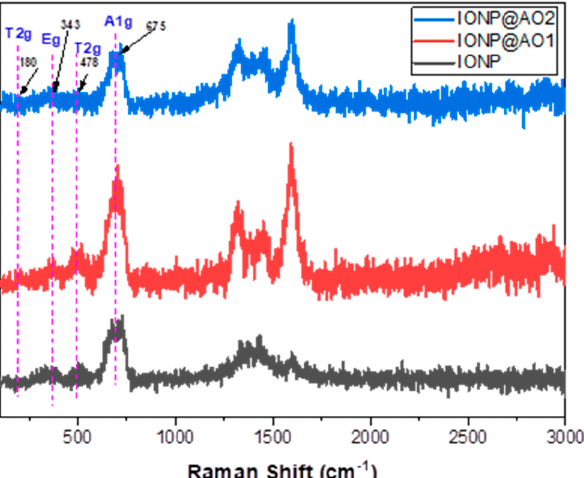
Figure 4. Raman spectroscopy analysis of unfunctionalized IONP and functionalized IONP@AO.